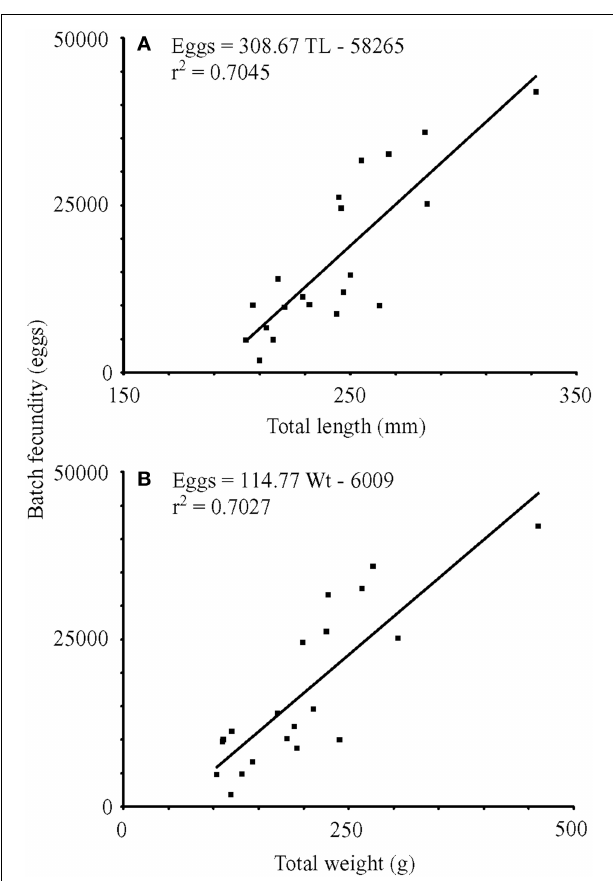
FIGURE 5 | Linear regressions of batch fecundity vs. (A) total length (mm) and (B) wet mass (g). TL, total length (mm); Wt, wet mass (g); r 2 , coefficient of